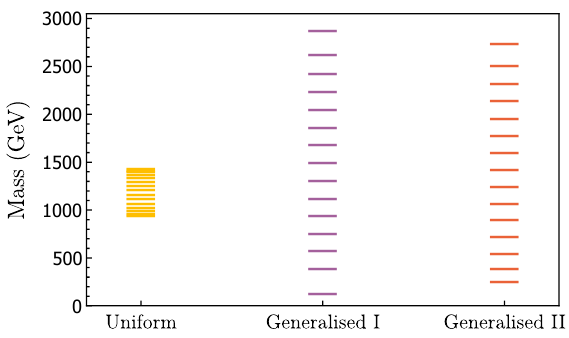
Figure 3 . Spectrum of clockwork neutrinos in the uniform CW (left) and generalized Linear CW1 (center) and Linear CW2 (right) models. (For discussion of generalized CW models, see section 4.) In all cases, N = 15, m = v , and y = 0 : 01; q = 4 : 887 (uniform), 0 : 76 (LCW1) and 0 : 73 (LCW2). The parameters were chosen so that the pseudo-zero mode neutrino mass is m (cid:23) = 8 all